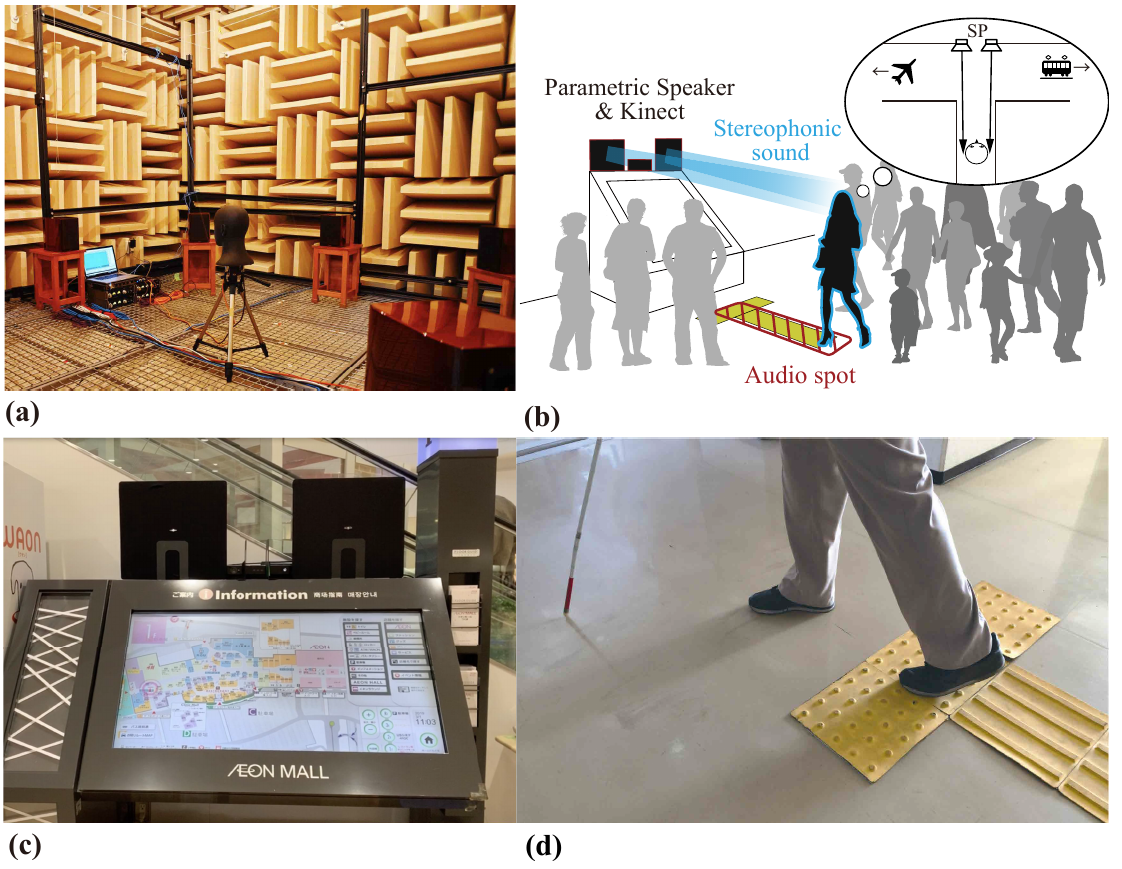
Figure 1. ( a ) Head transfer function (HRTF) is measured using a dummy head. A stereophonic